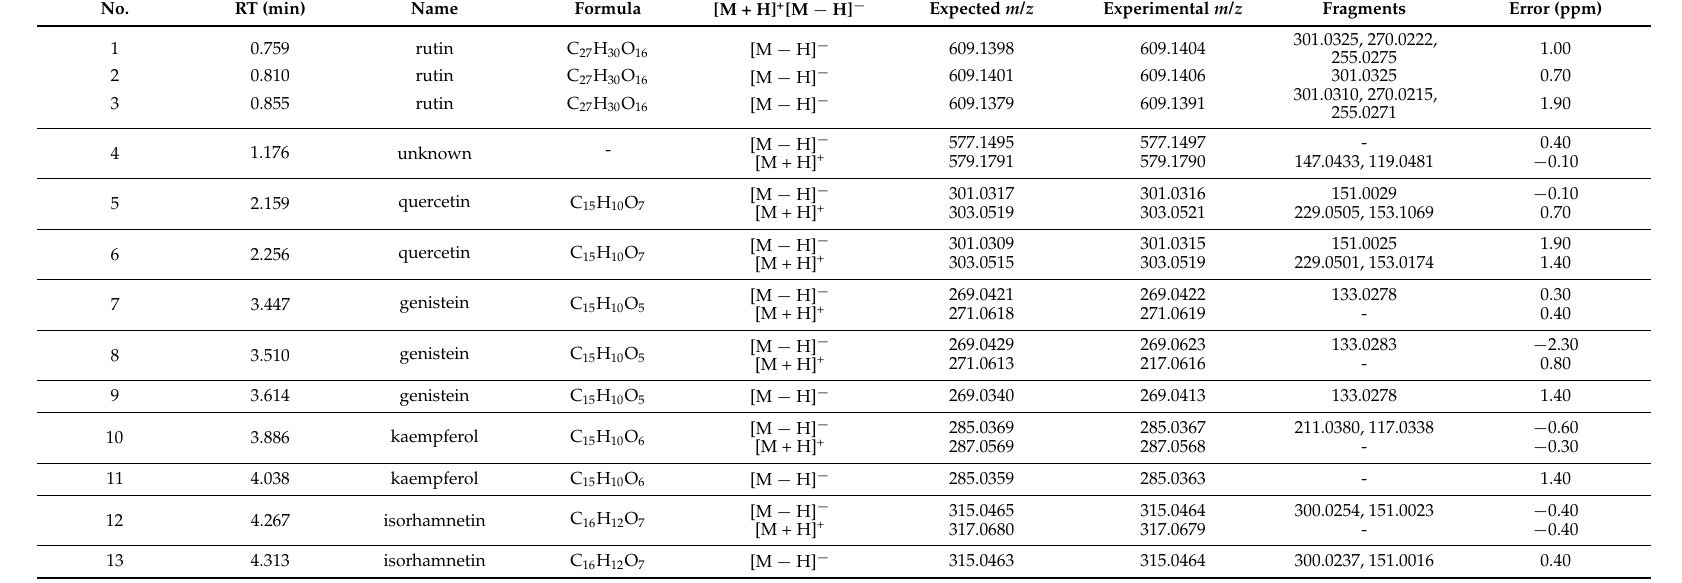
Table 5. Precursor and product ion of the ingredients in the methanol extract of FSI in UHPLC-ESI-Q-TOF